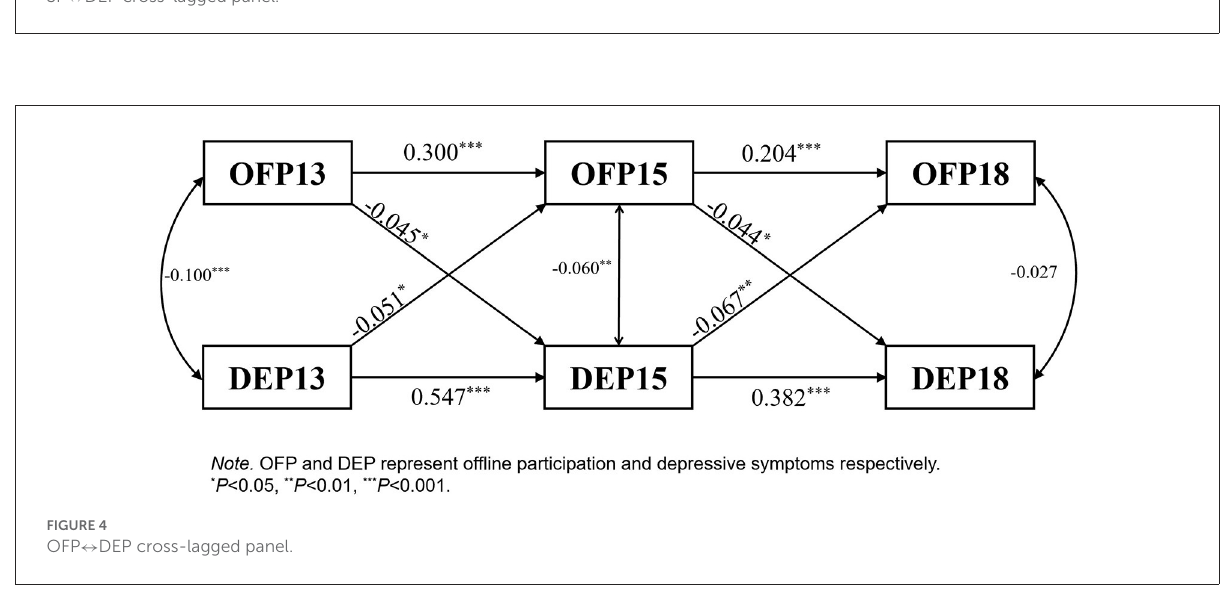
FIGURE3 SP ↔ DEP cross-lagged panel.